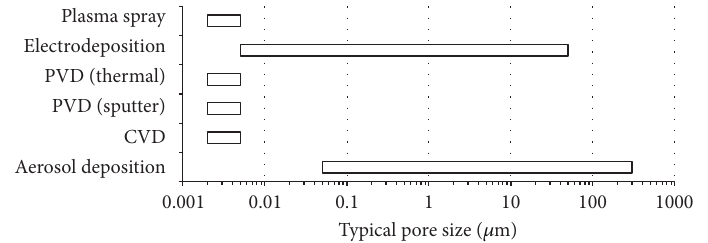
Figure 2: Summary of typical pore size for presented processes.